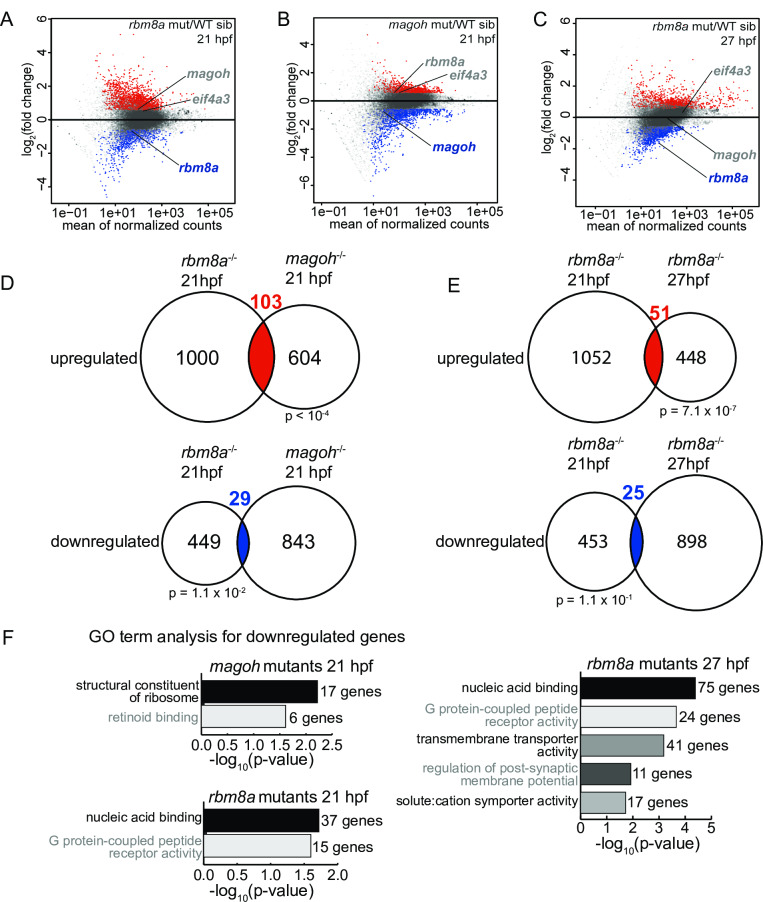
Gene expression changes in rbm8a and magoh mutant embryos.A-C. MA plots (M: log ratio; A: mean average) showing genes that are upregulated (fold change > 1.5 and FDR < 0.05) (red), downregulated (fold change < 1.5 and FDR < 0.05) (blue), or unchanged (gray) in rbm8a mutant embryos compared to WT siblings at 21 hpf (A), magoh mutant embryos compared to WT siblings at 21 hpf (B), and rbm8a mutant embryos compared to WT siblings at 27 hpf (C). rbm8a, magoh, and eif4a3 are labeled in each plot with label colors signifying no change (gray) or downregulation (blue). D. Venn diagrams showing the overlap between genes that are upregulated (top) and downregulated (bottom) in rbm8a mutant embryos at 21 hpf (left) and magoh mutant embryos at 21 hpf (right). Hypergeometric test p-values are below each comparison. E. Venn diagrams as in (D) comparing upregulated and downregulated genes in rbm8a at 21 (left) and 27 hpf (right). F. PANTHER14.0 [86] gene ontology (GO) term overrepresentation analysis of genes downregulated in rbm8a and magoh mutant embryos at indicated times. All significant terms (Benjamini-Hochberg corrected p-value < 0.05) are shown for each set. The number of genes in each term is indicated at the right of each bar.